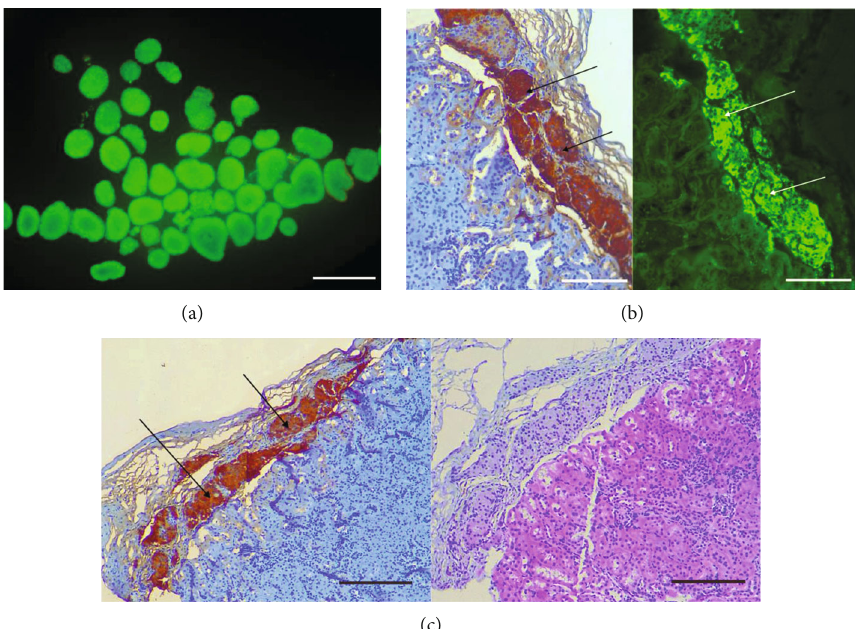
Figure 1: Evaluation of islets vitality, location, and function after transplantation. (a) Viability evaluation of pancreatic islets (FDA/PI staining: × 200). Scale bar = 50 μ m . (b) The activity of islets transplanted under renal capsule was high and insulin secretion was normal (The arrow points to the positive expression of insulin antibody, immunohistochemical staining: × 200; immuno fl uorescence staining: × 200). Scale bar = 50 μ m . (c) Transplanted islets were at a high activity under the kidney capsule (The arrow points to the positive expression of insulin antibody, immunohistochemical staining: × 100; HE staining: × 100). Scale bar = 100 μ m